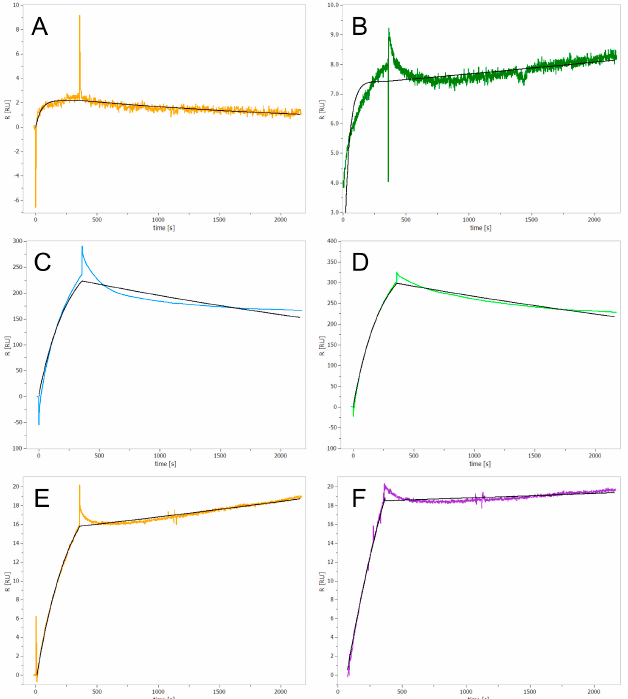
Figure 2. SPR sensorgrams of the ClpP inhibitors at 80 µ M concentration. Each compound was injected over 7 min, followed by 30 min of dissociation time. ( A ) Bortezomib, ( B ) Cefmetazole, ( C ) cDPCP, ( D ) Cisplatin, ( E ) 3,4-DIC, and ( F ) Z-LY-CMK (covalent binder, control). The fitting curves of the SPR sensorgrams (black lines) were obtained using a 1:1 Langmuir interaction model.